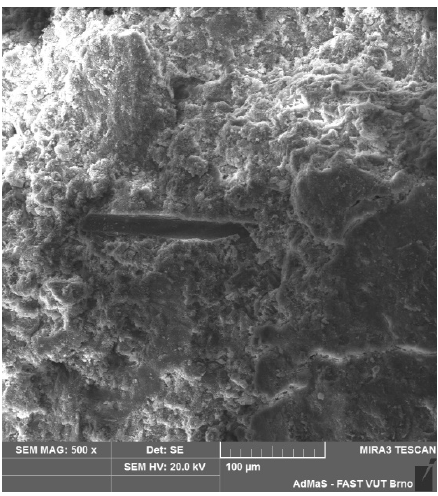
Figure 11. REC 2–20 °C (2000×).